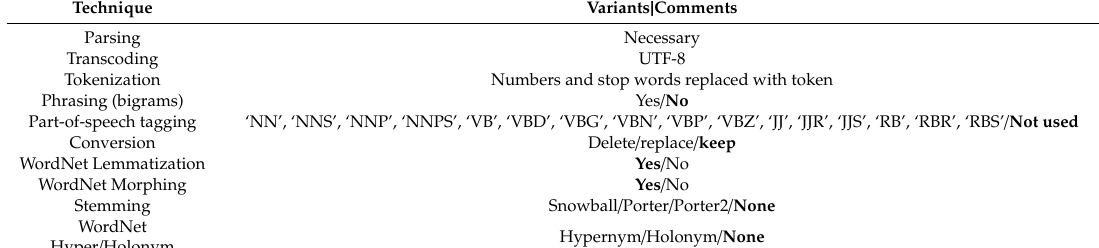
Table 2. Valuated techniques of text pre-processing.